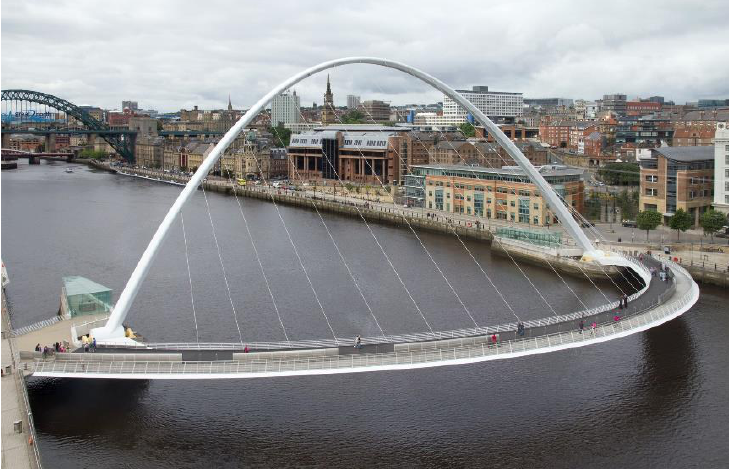
Figure 2. Gateshead Millennium footbridge (Photo: David P. Howard. Creative Commons).